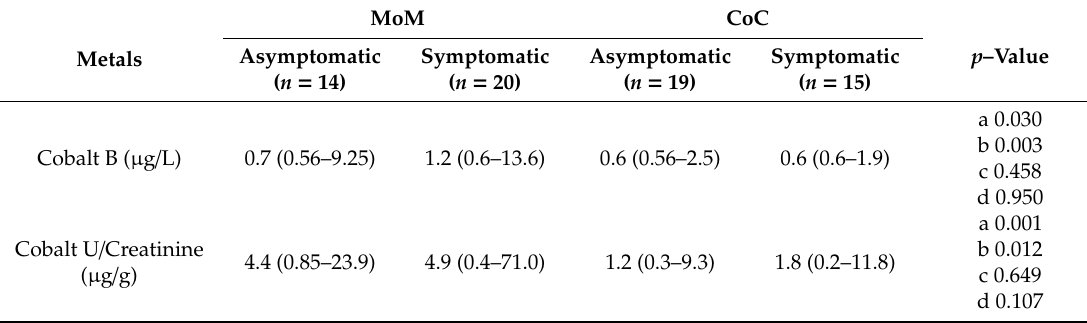
Table 5. Metal ion concentration comparing asymptomatic and symptomatic